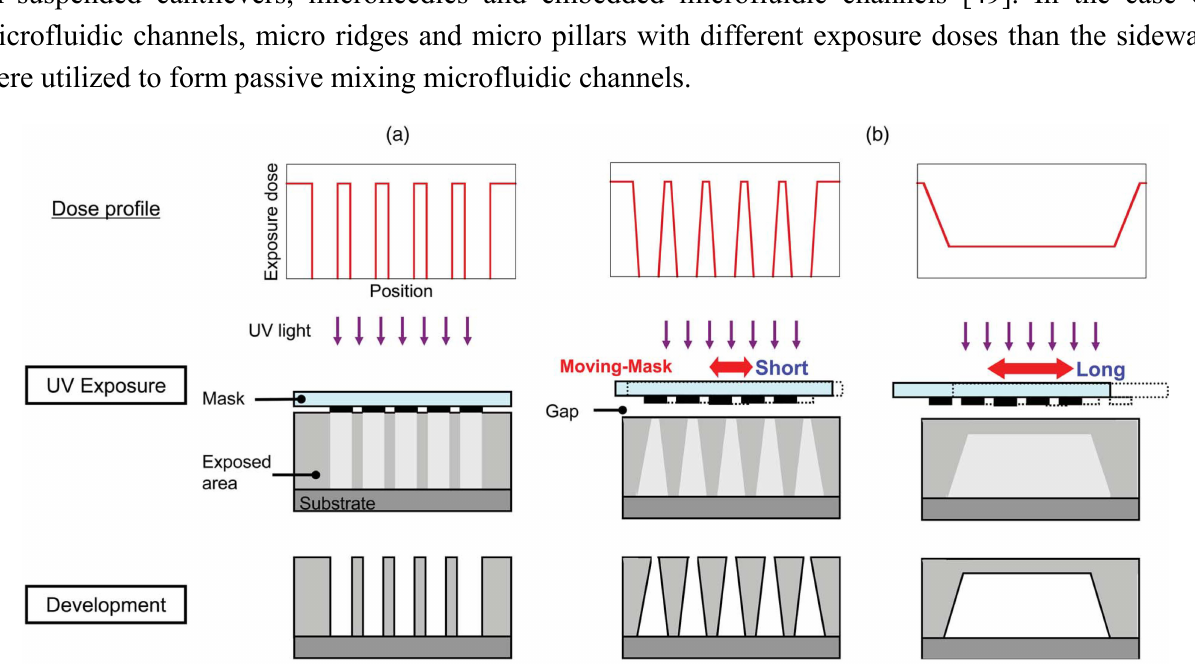
Figure 15. Exposure dose profile on the photoresist and conceptual illustration of 3D thick microstructures using a negative-tone photoresist: ( a ) standard photolithography and ( b ) moving-mask lithography. Reprinted with permission from [45], copyright 2010